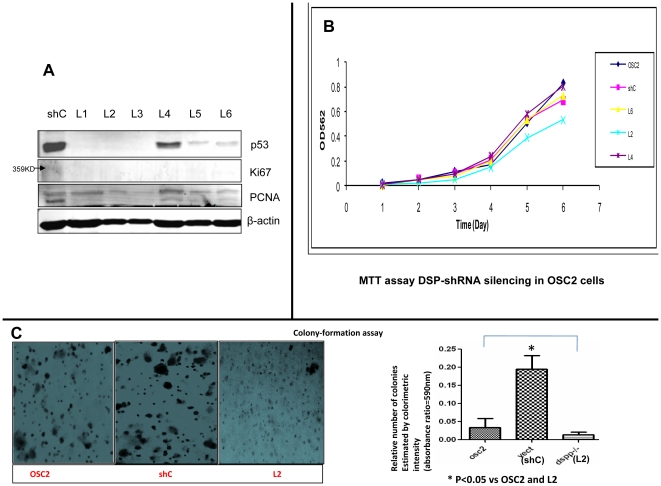

DSPP-silencing results in dowregulation of Ki-67, PCNA, p53, and inhibition of cell proliferation and colony-formation.(A) WB of ki-67, PCNA, and p53 following DSPP-silencing in OSC2 cells show significant downregulation for each of these proteins. (B) The proliferation status of DSPP-silenced OSC2 cells compared to parental OSC2 and shC control carried out via MTT assay shows decreased cell proliferation of 53% for L2 (demonstrating the most degree of silencing) compared with <5% for L4 (least silencing), and ∼30% for L6 (moderate silencing) and shC control (p<0.05; n = 3). (C) L2 cells formed smaller and significantly fewer (<25%) colonies in soft agar compared with parental OSC2 and shC control cells (*p<0.05).